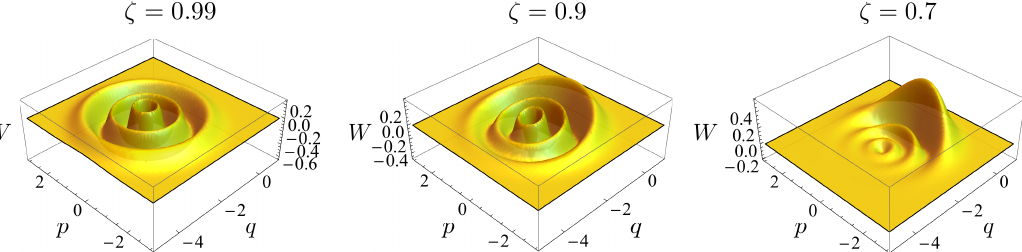
(cid:82) ∗ ϕ 2 ipy ϕ − y ) of the state | ϕ R d y e 5 ( q + y ) 5 ( q π